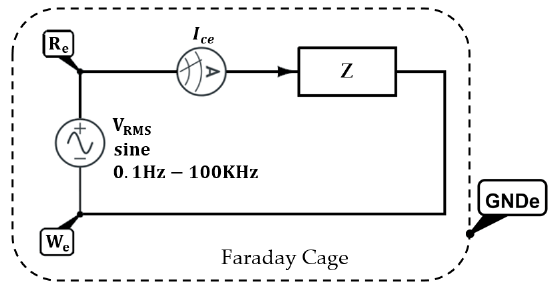
Figure 1. EIS circuit setup. Counter electrode current ( I ce ), reference electrode ( R e ), working electrode ( W e ), ground electrode (GNDe), and circuit impedance ( Z ).